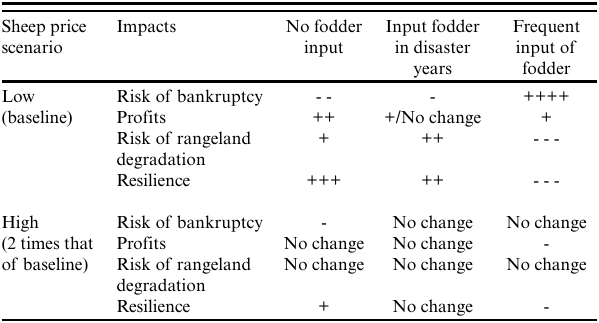
Table 5 . Summary of impacts of credit